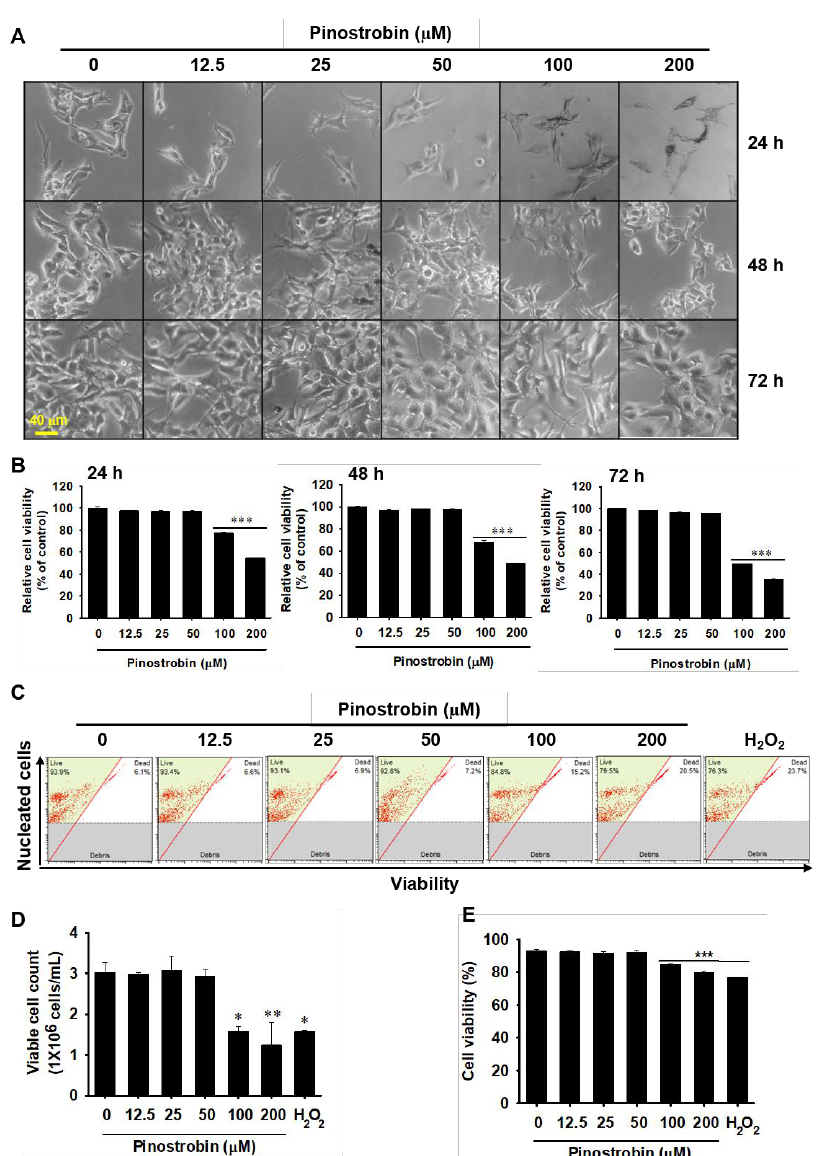
Figure 3. Pinostrobin at concentrations below 50 μM is not toxic to B16F10 melanoma cells. B16F10 cells were treated with pinostrobin (0 – 200 µM) for 72 h. ( A ) Microscopic images captured every 24 h. Scale bar = 40 μ m. ( B ) Relative cell viability presented relative to the values of the untreated cells. ( C ) Treatment of cells with pinostrobin for 72 h. The cells were stained with a Muse Cell Count and Viability Kit. ( D ) Viable cell counts; ( E ) cell viability. Data are reported as mean ± SE. * p < 0.05, ** p < 0.01, and *** p < 0.001 vs. untreated cells.